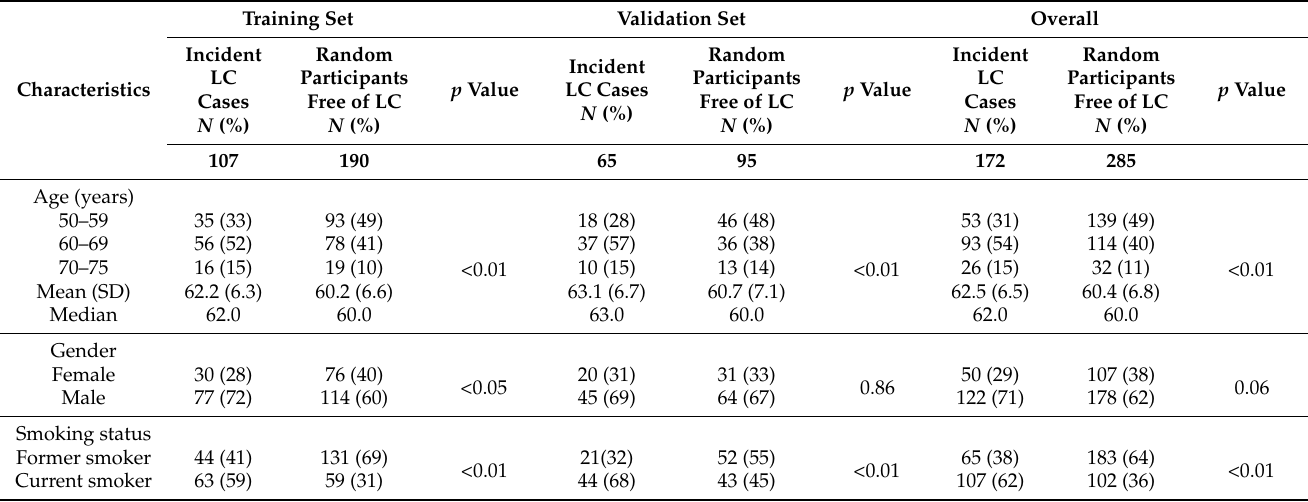
Table 1. Characteristics of the ever smoking